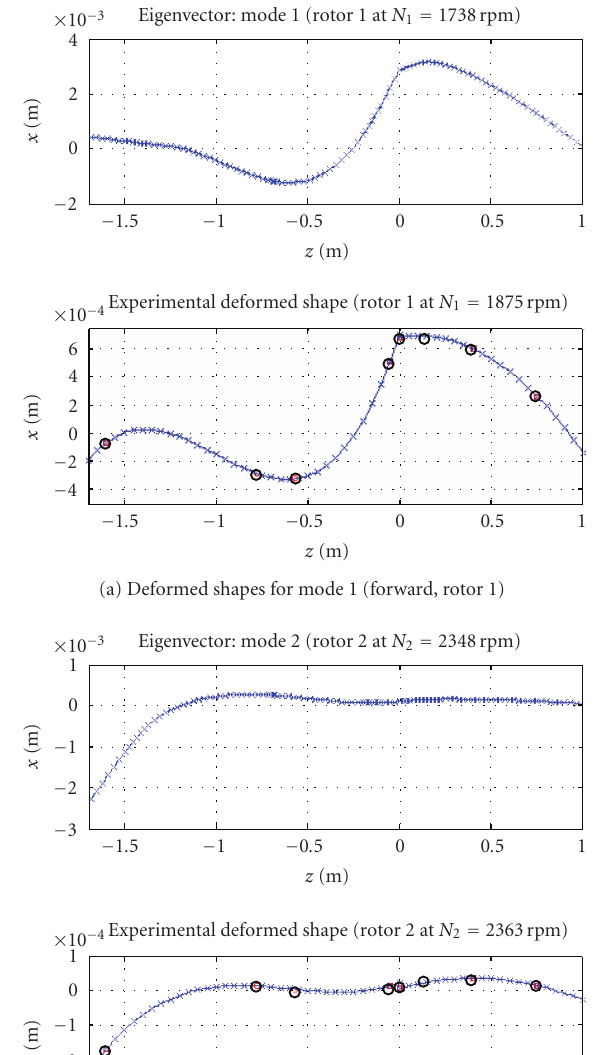
Experimental deformed shape (rotor 2 at N 2 = 2363rpm)